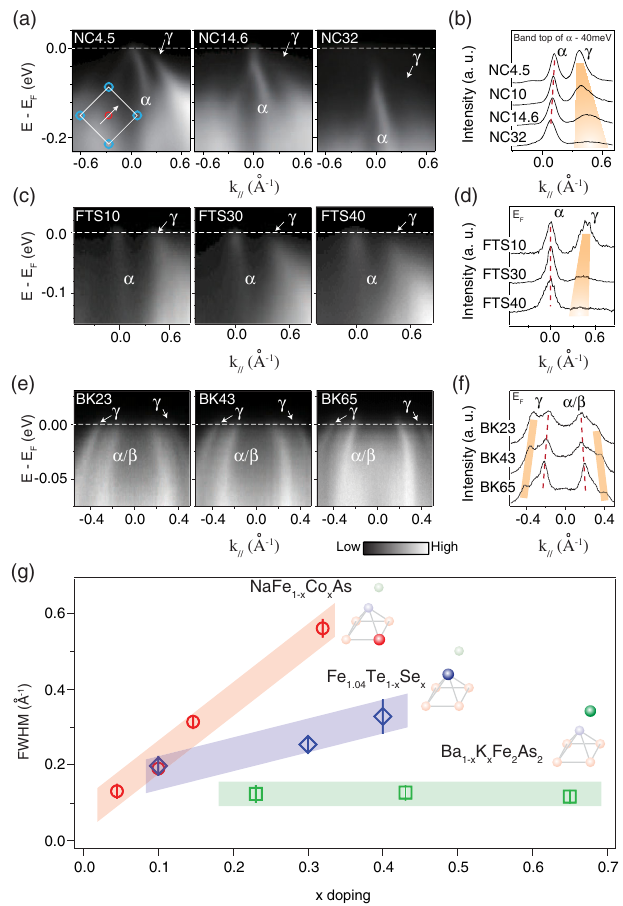
FIG. 2. (a) Doping dependence of the photoemission intensity distribution in NaFe 1 − x Co x As parallel to the Γ -X direction, as indicated by the inset. (b) Doping dependence of the MDCs at 50 meV below the band top of α . Note that the increasing binding energy could only contribute a small increase to FWHM, which is less than 0 . 05 Å − 1 , as shown in Fig. 1(e). Panels (c), (d), (e), and (f) are the same as (a) and (b), but for Fe 1 Te 1 − x Se x and . 04 Ba 1 − x K x Fe 2 As 2 , respectively. The MDCs in (d) and (f) were extracted from E F . Note that the data for NaFe 1 − x Co x As and Fe 1 Te 1 − x Se x were taken with s polarized photons, and those for . 04 Ba 1 − x K x Fe 2 As 2 were taken with mixed polarized photons. Panel (g) summarizes the doping evolutions of the FWHMs of the γ bands in NaFe 1 − x Co x As, Fe 1 Te 1 − x Se x and Ba 1 − x K x Fe 2 As 2 . 04 series. The error bars of FWHMs in panel (g) are standard deviations of the Lorentzian fit to MDC